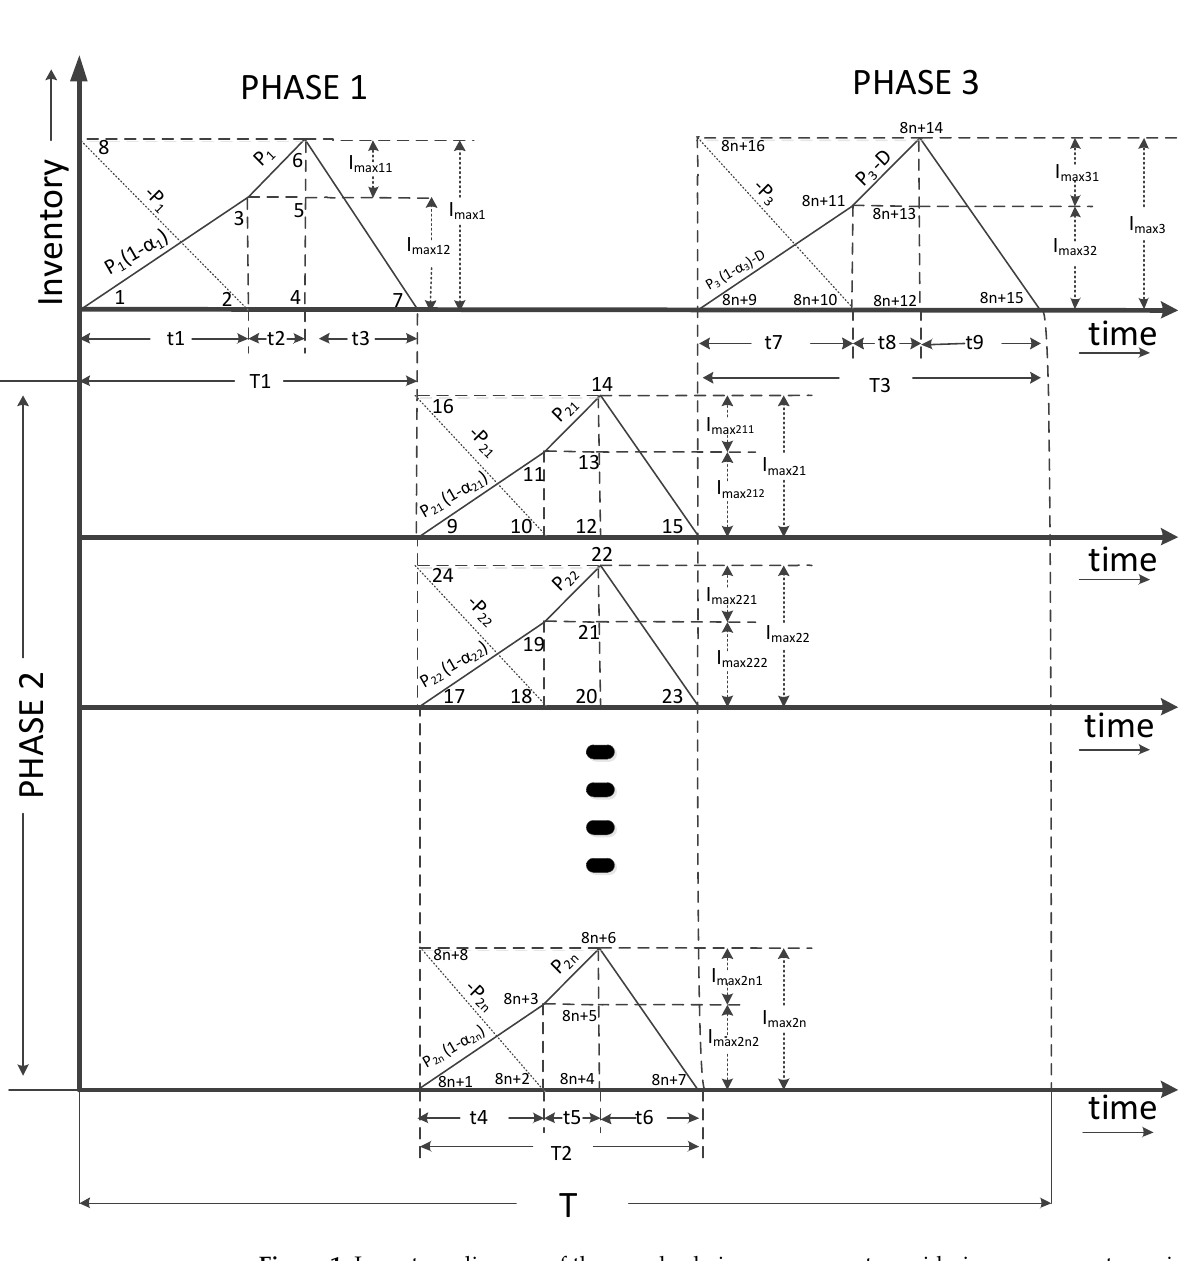
Figure 1. Inventory diagram of the supply chain management considering process outsourcing.